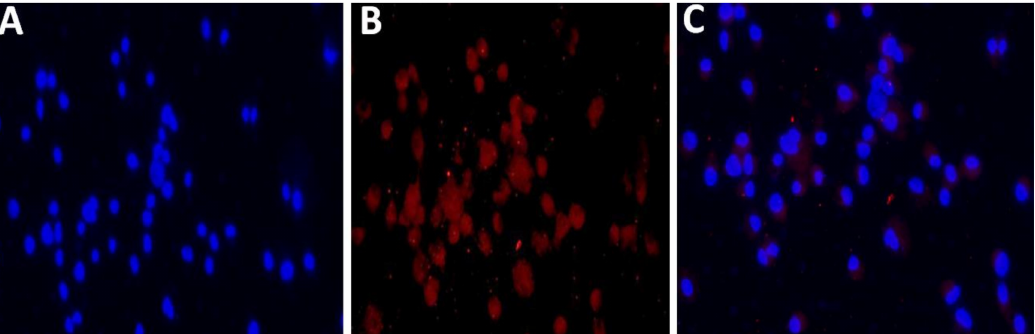
Figure 7. Fluorescence microscopy images of immunofluorescence staining of Caco-2 cell monolayers. Caco-2 cells were incubated with fluorescent NR-NLC for 3 h. The cell nuclei were stained by DAPI ( A ), and the nanoparticles were labeled by Nile Red ( B ). The merge images of the nucleus (blue) and NLCs (red) ( C ). With magnification 40 ×